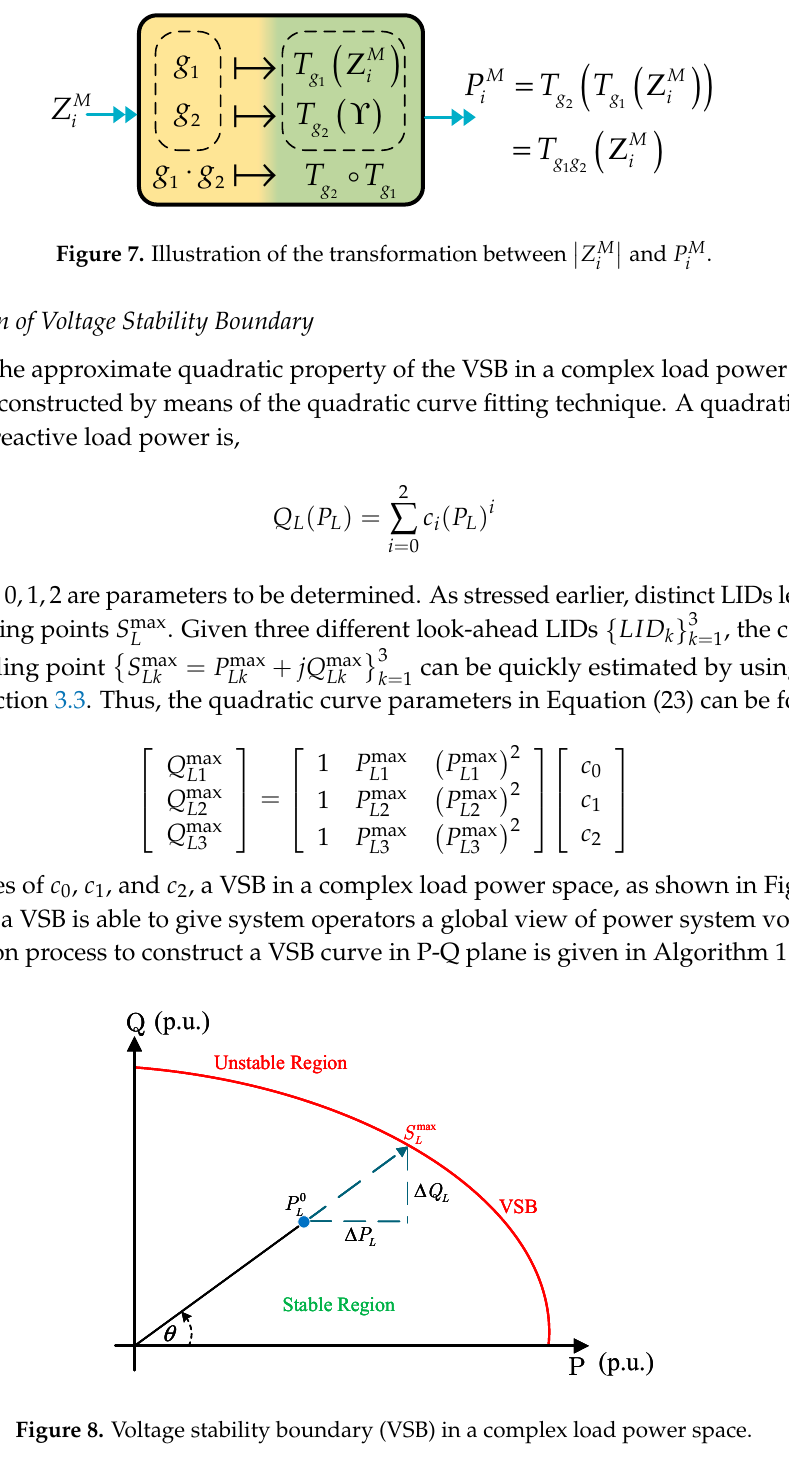
Figure 7. Illustration of the transformation between M